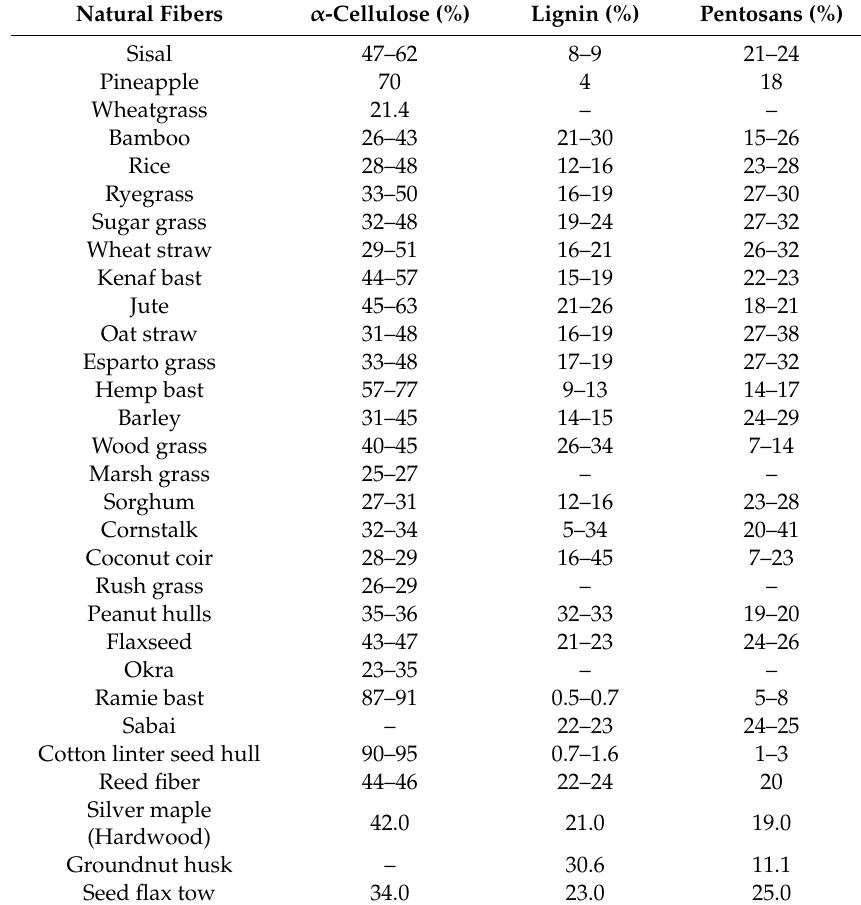
Table 10. Composition of selected natural fibers used in FRPs